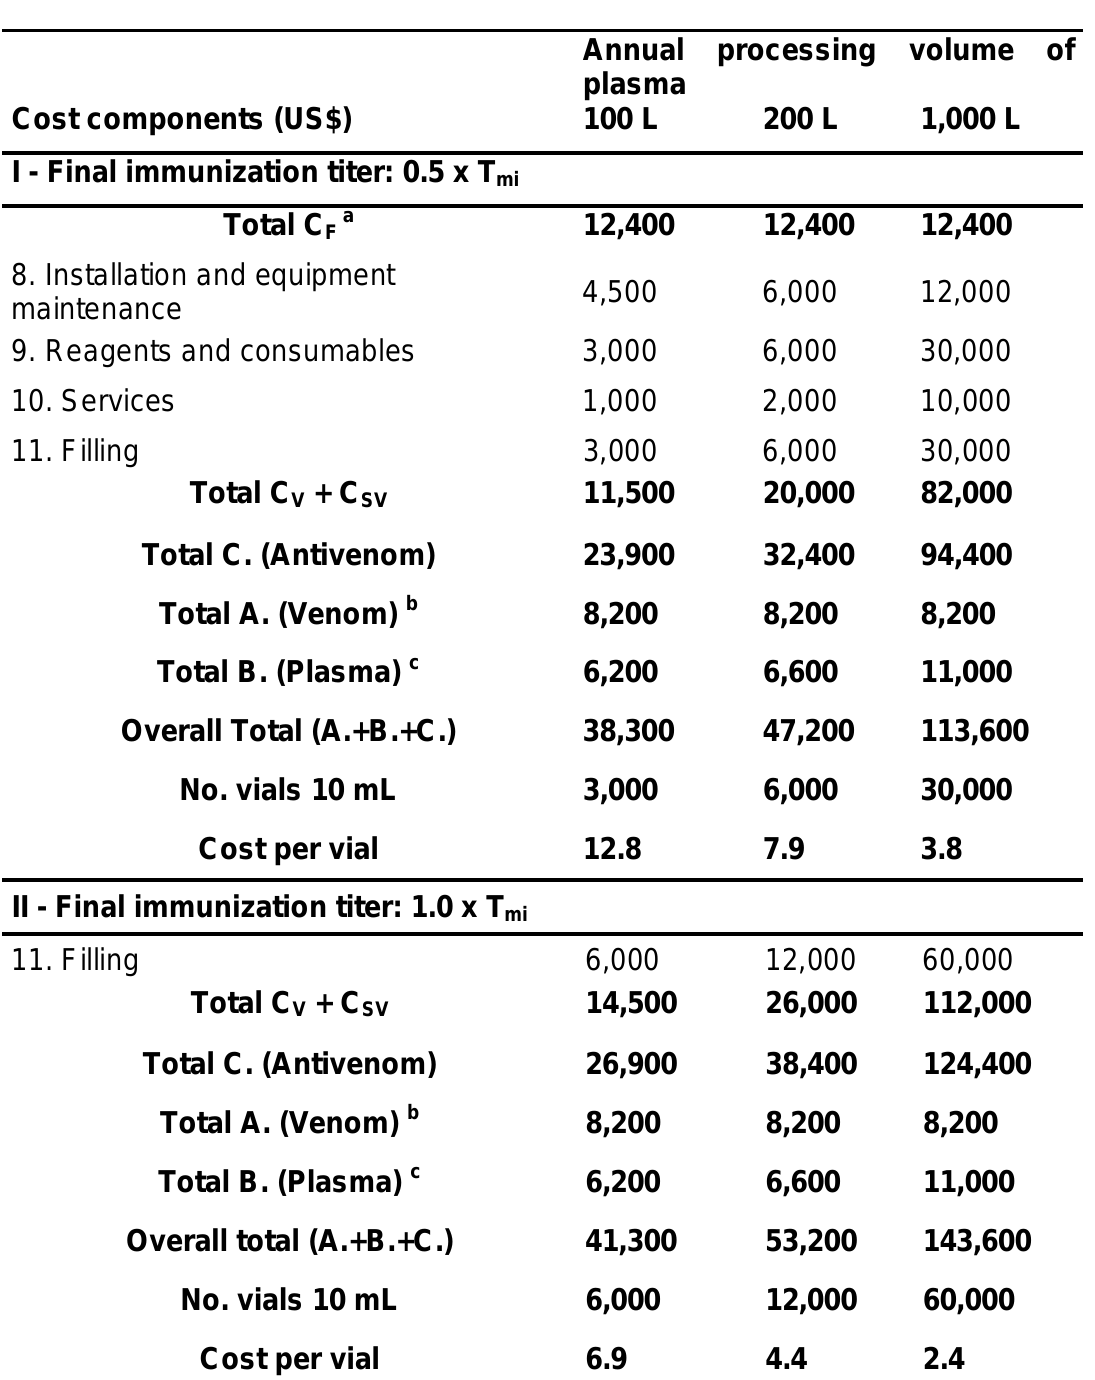
Table 5: Costs associated to the third stage of snake antivenom production: C. Antivenom production; total cost and unitary cost. Overall process activity yield as IgG: